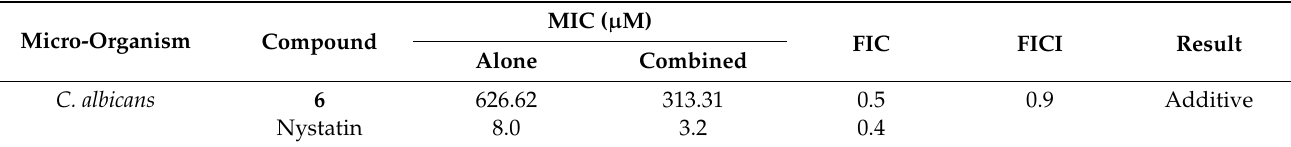
Table 5. Synergistic effect observed with the Checkerboard method for compound 6 with nystatin against C. albicans .